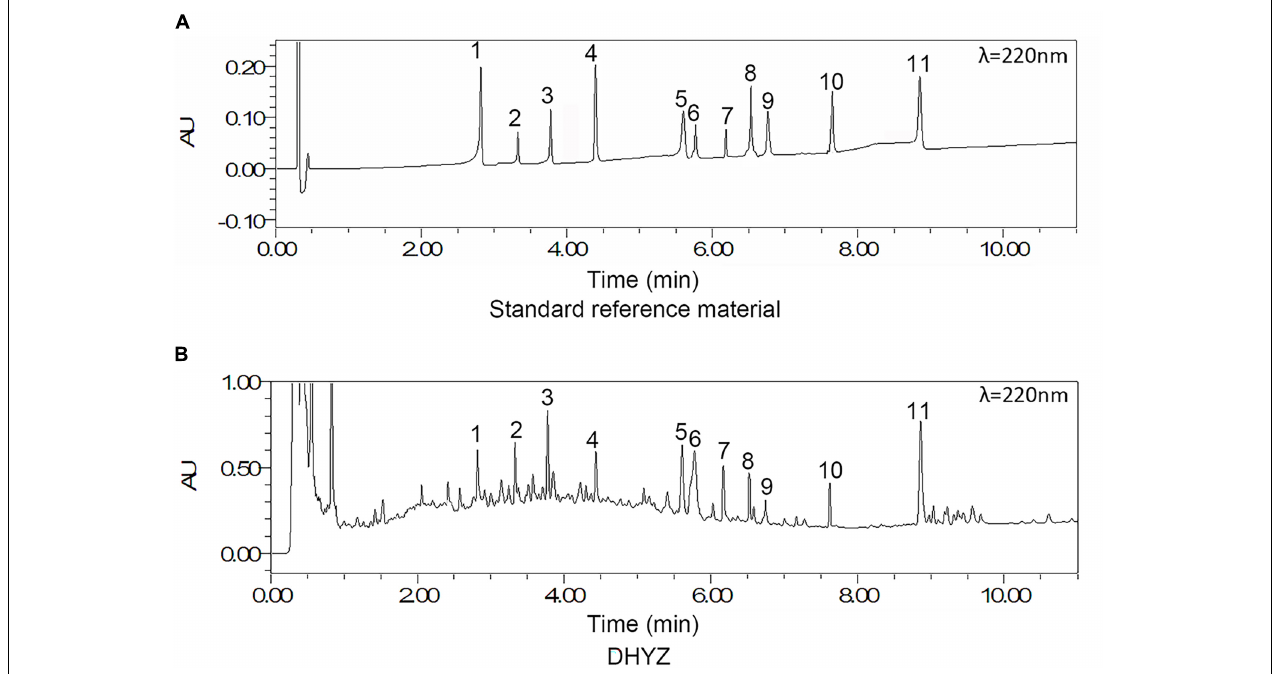
FIGURE 2 | UPLC-UV chromatograms of DHYZ at 220 nm. Representative chromatograms of standard reference compound (A) and DHYZ (B) were shown respectively. Peak no.: 1. loganin, 2. echinacoside, 3. verbascoside, 4. erianin, 5. cinnamic acid, 6. tenuifolin, 7. quercetin, 8. ruscogenin, 9. kaempferol, 10. beta-sitosterol, and 11. schisandrin